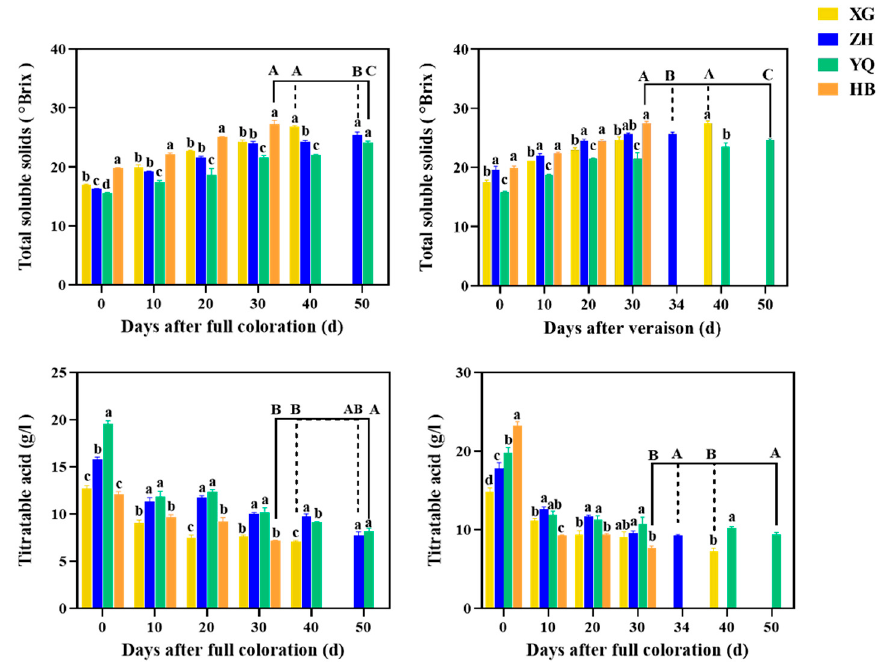
Figure 2. Changes of total soluble solids (TSS) and titratable acid (TA) content during ripening in ‘Cabernet sauvignon’ ( left ) and ‘Marselan’ ( right ) grape berries from four sub-regions. Different lowercase letters indicate significant differences between the samples from different sub-regions at the indicated time. Different capital letters indicate significant differences between berries from different sub-regions at the commercial harvest (Duncan’s test, p < 0.05).